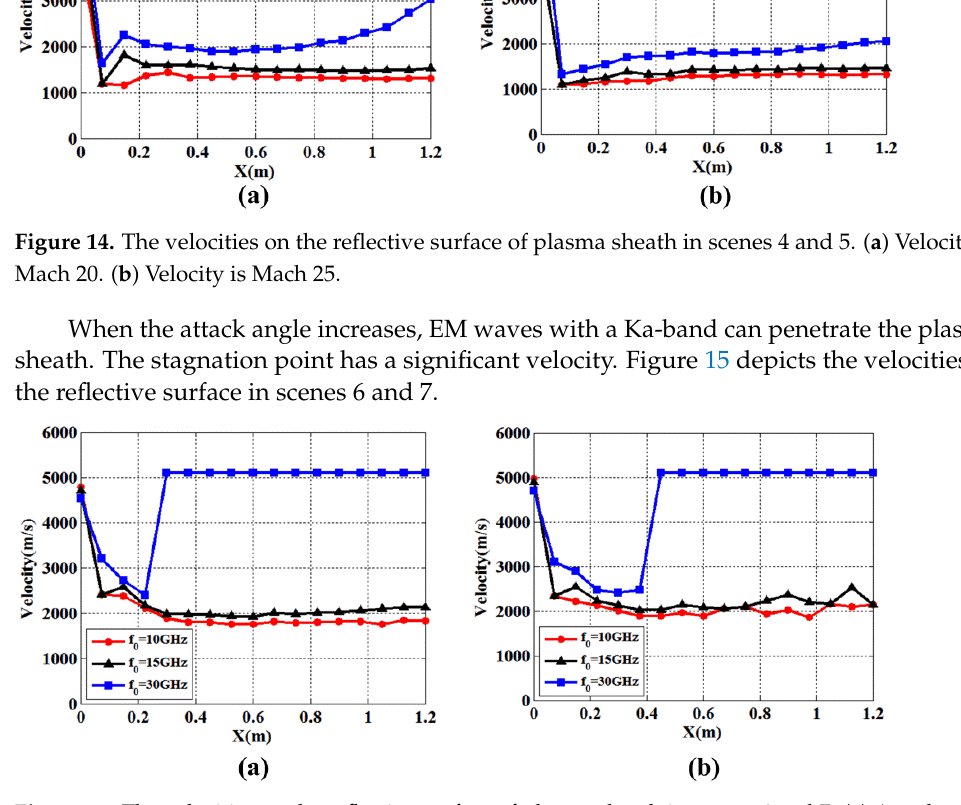
Figure 15. The velocities on the reflective surface of plasma sheath in scenes 6 and 7. ( a ) Attack angle is 10°. ( b ) Attack angle is 20°.